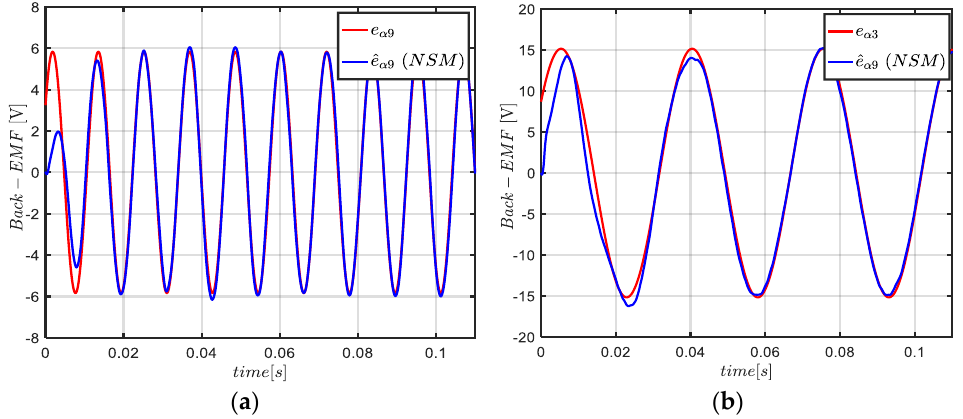
Figure 14. Simulated waveforms of the actual and estimated α -axis back EMF using the neural synchronous method: ( a ) the 9th harmonic in SM, ( b ) the 3rd harmonic in TM.